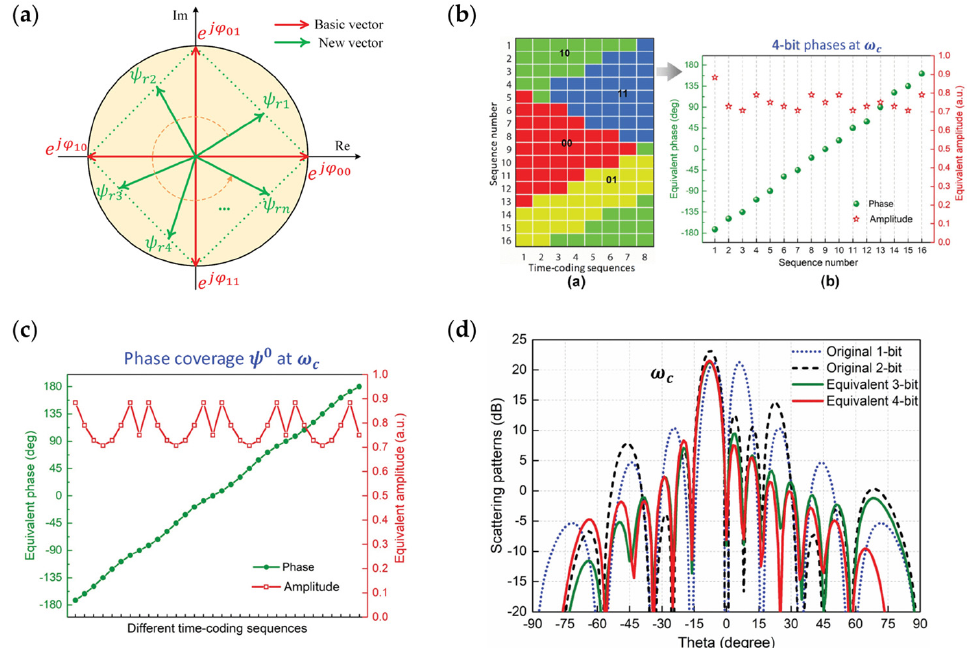
Figure 9. ( a ) Schematic of time modulation on reconfigurable metasurface to achieve any phase response in 2 π ; ( b ) Equivalent 2-bit phase response achieved by time modulation; ( c ) Realizing of a higher bit number of equivalent phase responses with a longer coding sequence; ( d ) A comparison among the performances of beam steering with equivalent 1, 2, 3 and 4-bit number© 2023 IEEE. Reprinted, with permission, from [43] .